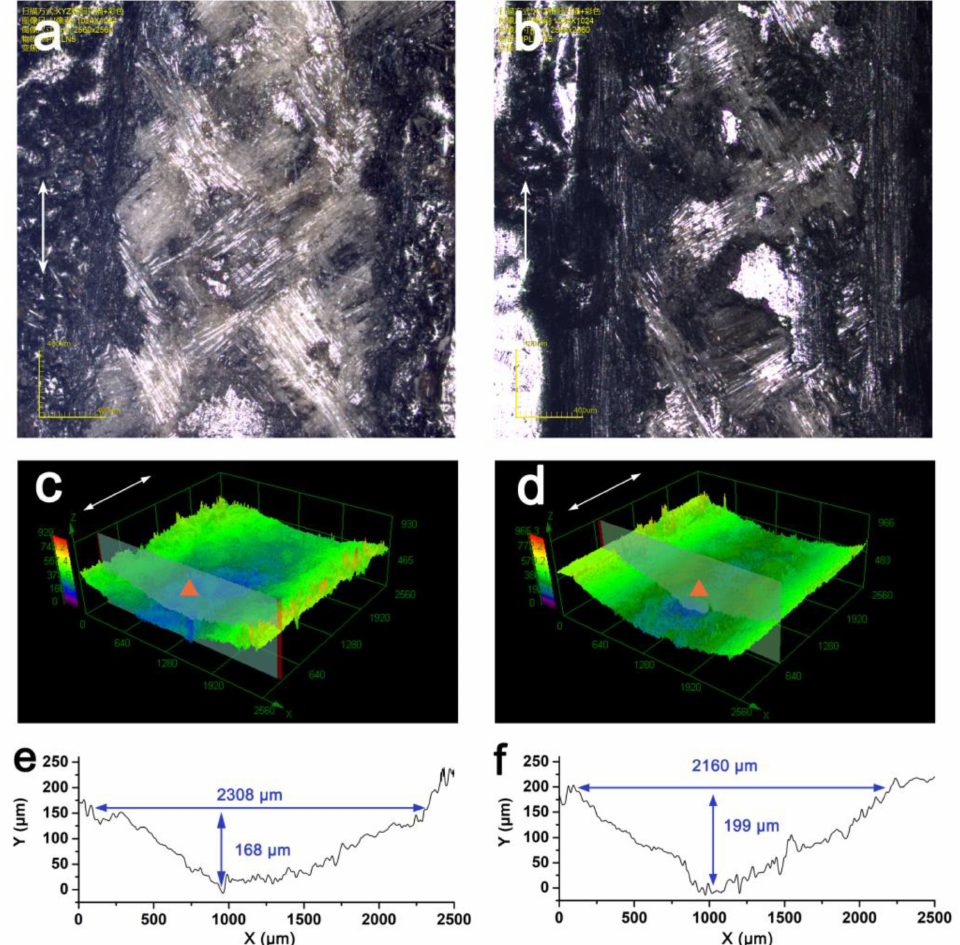
Figure 10. Morphology of worn surface of coating preparation: ( a , b ) Optical images of worn surface, ( c , d ) 3D surface topography, and ( e , f ) surface profiles with C-0.05 g ( a , c , e ) or C-0.2 g ( b , d , f